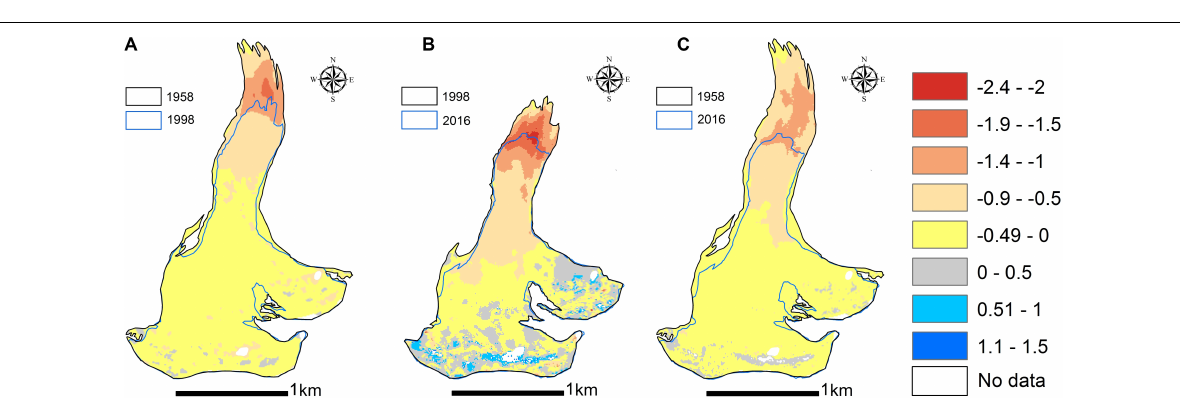
FIGURE 4 | Annual rates of change in the surface elevation of the Central Tuyuksu glacier (m a − 1 ): (A) 1958–1998; (B) 1998–2016; (C) 1958–2016. The solid line shows the glacier area at the beginning and at the end of each assessment